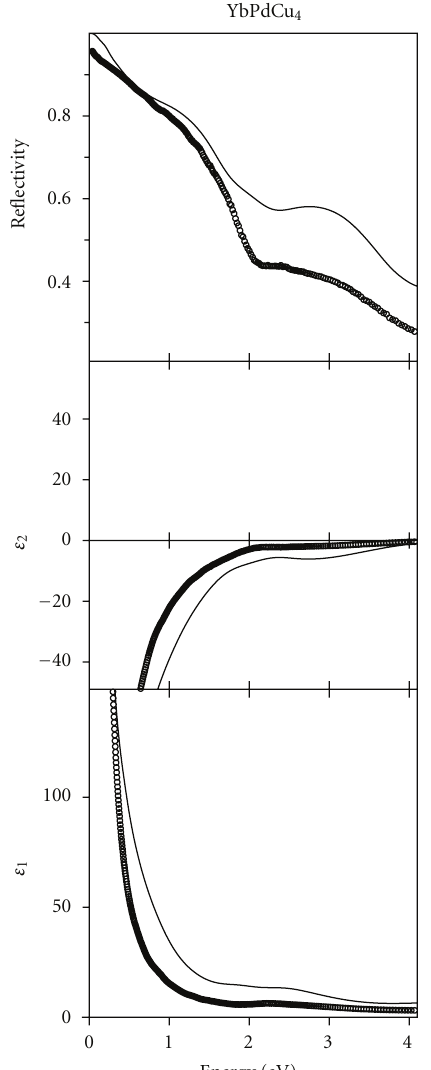
Figure 103: Comparison between the experimental (dots) and LSDA+ U calculated (solid line) optical spectra of YbPdCu 4 [475].